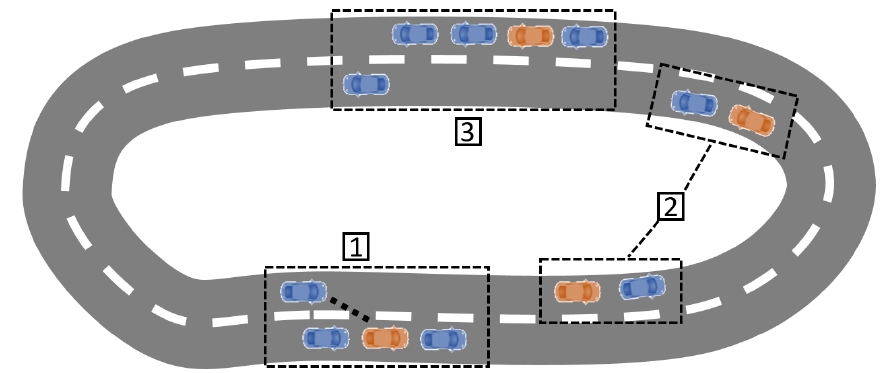
Figure 1. Relocation process. (1) The AV follower detects a leader. (2) A platoon is formed and drives together to the next parking spot. (3) The AV follower parks in the selected parking